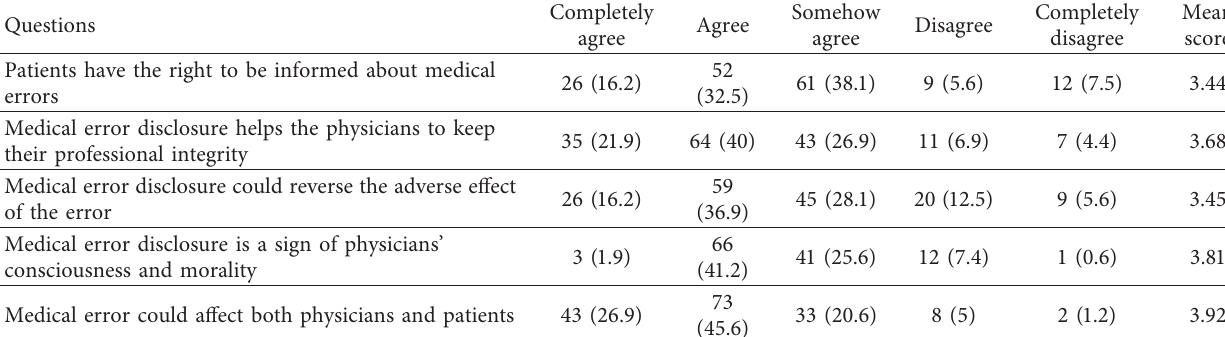
Table 5: Reasons for disclosing or not disclosing medical errors.